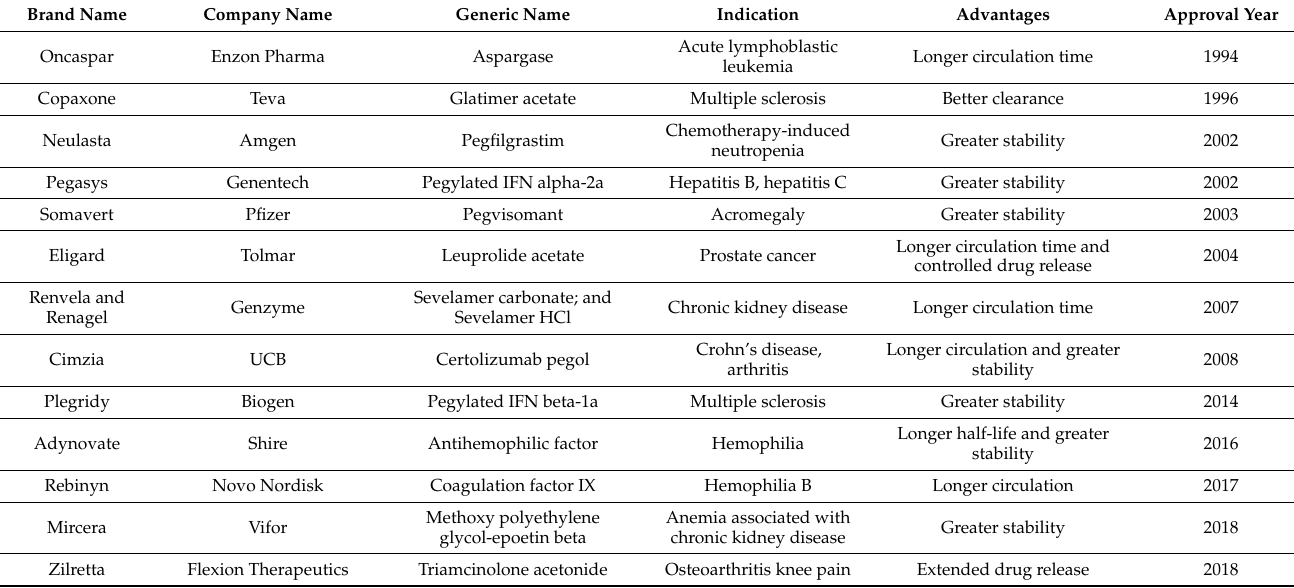
Table 7. The various polymeric nanoparticles-based medicines approved by USFDA with their timeline of approval